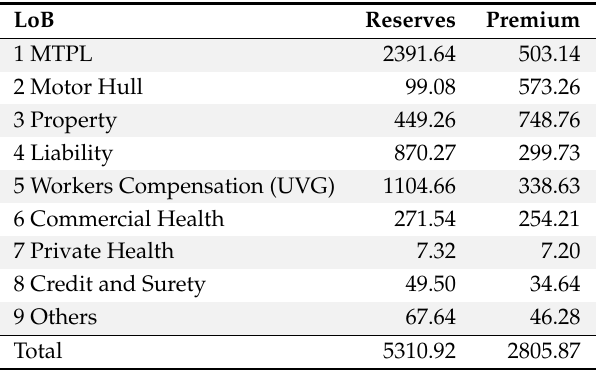
Table 1. Initial synthetic balance